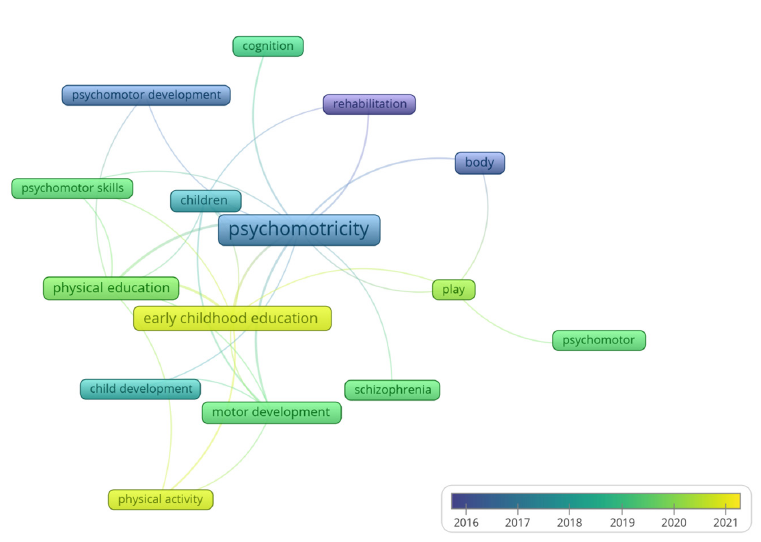
Figure 5. Most relevant authors’ keywords.